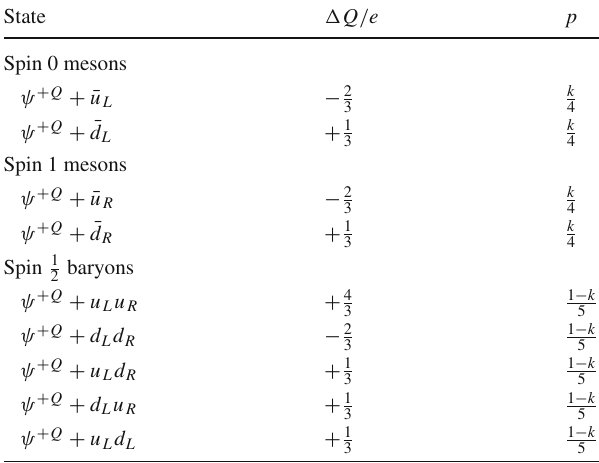
Table 2 A hadronisation model for a colour-triplet fermionic particle ( ψ + Q ).Thechargeshift (cid:10) Q andtheprobability p assignedtoeachstate are shown in the second and third columns, respectively. For fermionic particles, ψ , we consider hadronic states up to spin 1